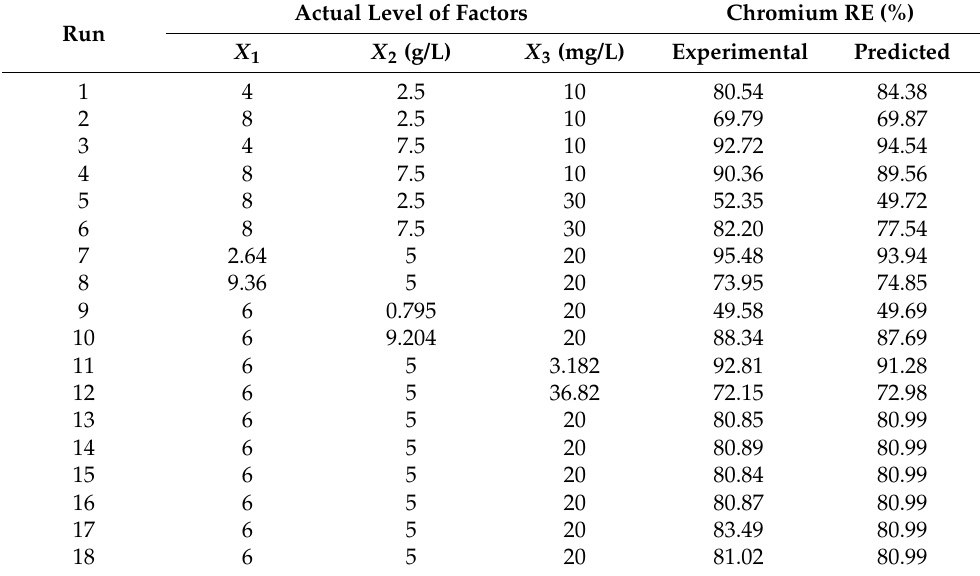
Table 2. Experimental design matrix and the